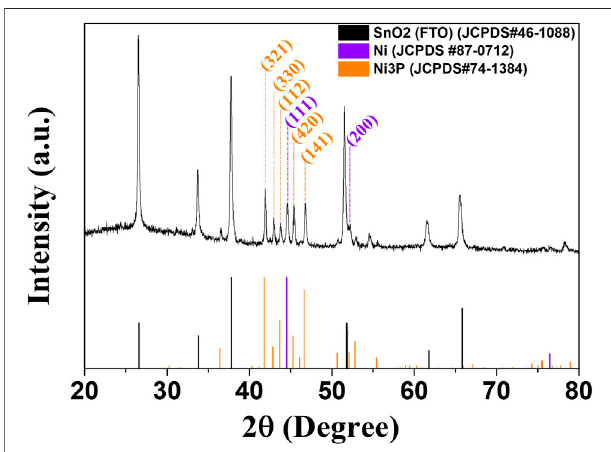
FIGURE 5 | XRD patterns of the annealed Ni 69 P 31 electrodeposit.